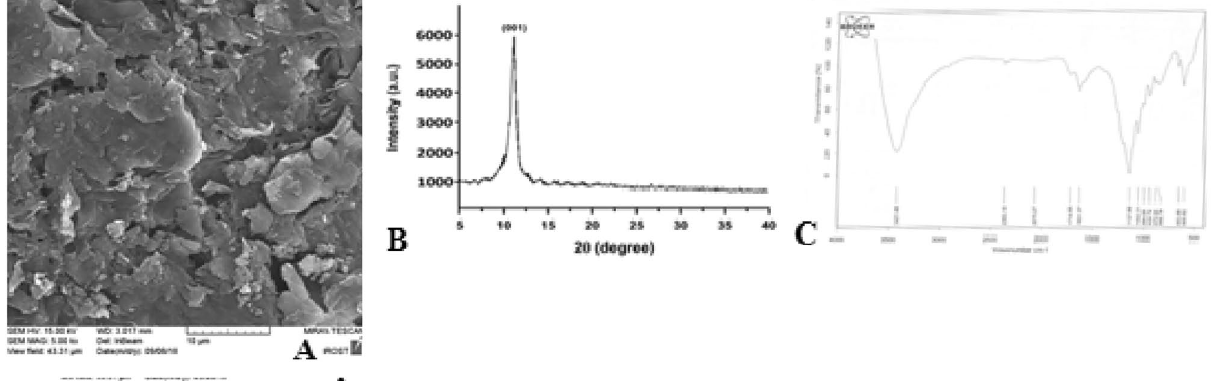
Figure 7. SEM ( A ), XRD spectra ( B ), and FT-IR spectra ( C ) of graphene oxide nanoparticles.